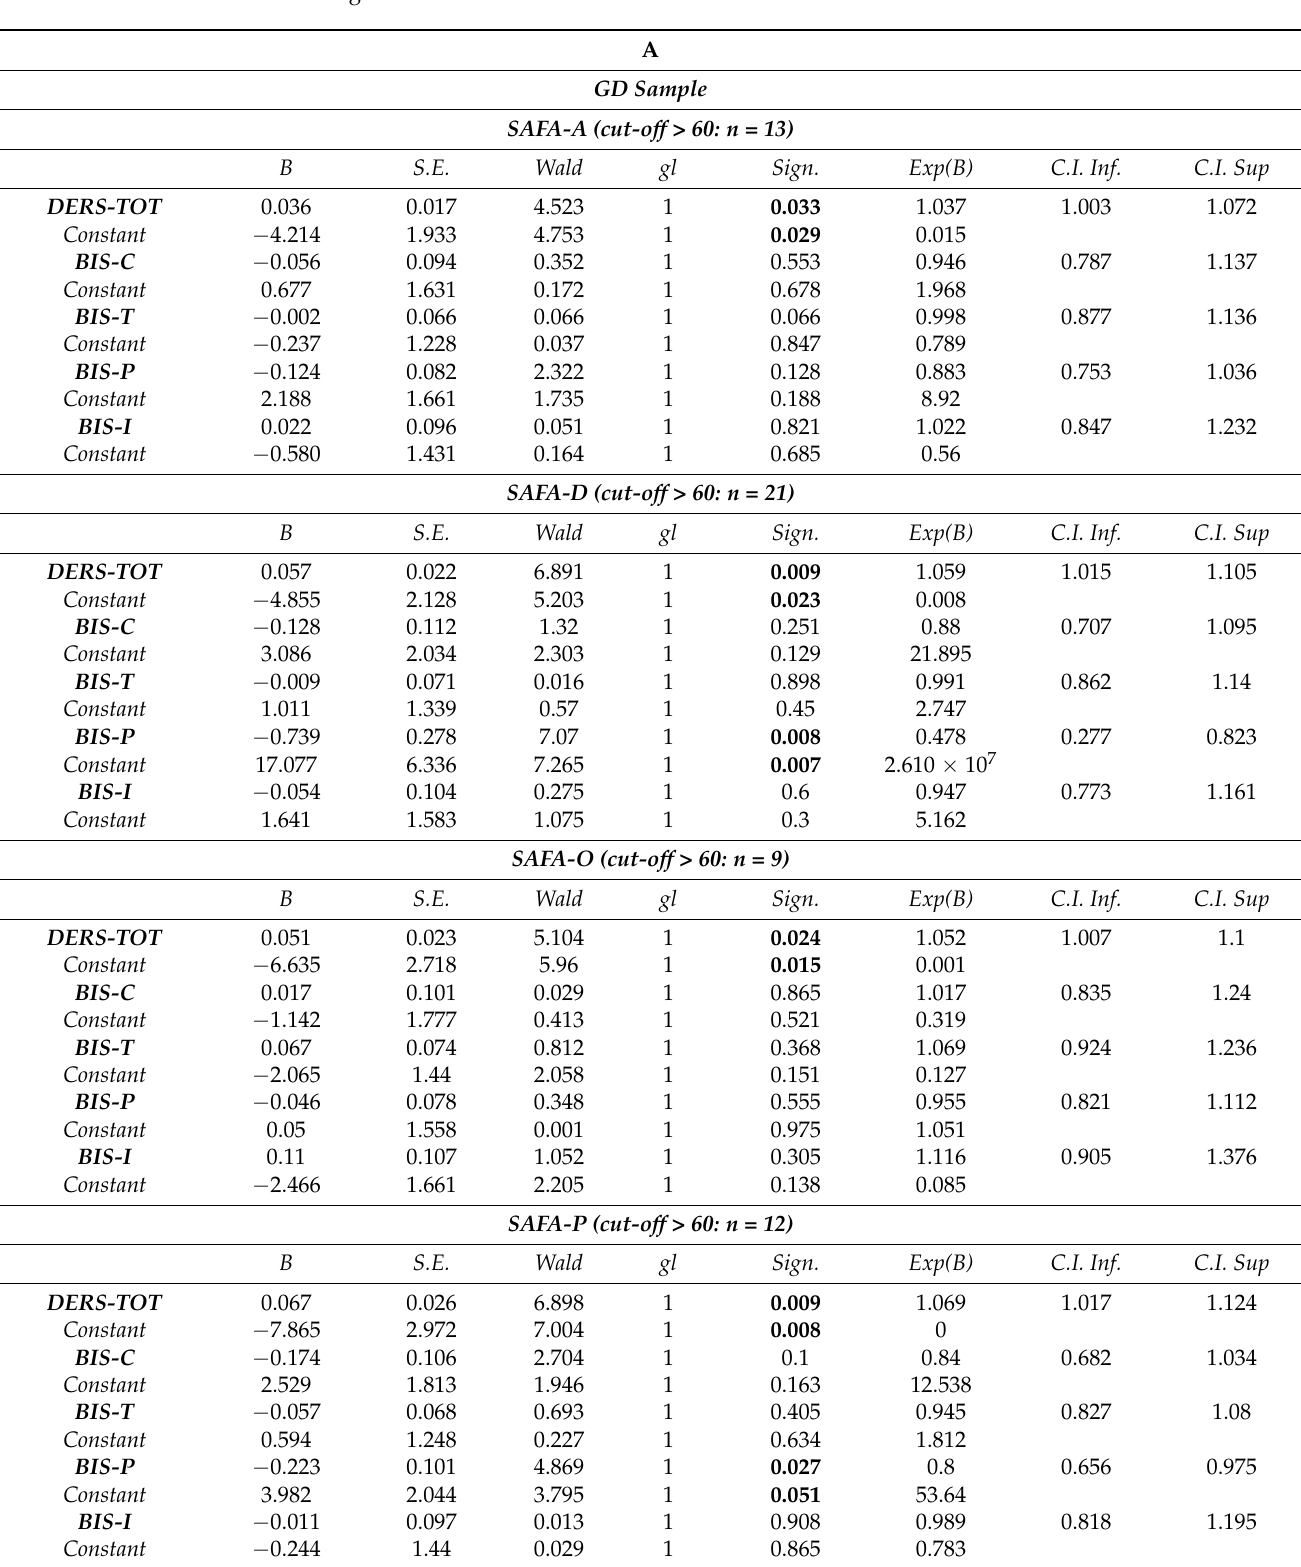
Table 4. Univariate logistic binary regression’s results for each SAFA scale as dependent vari- able and DERS-TOT and BIS domains as independent variables: A . gender dysphoria sample; B . cisgender